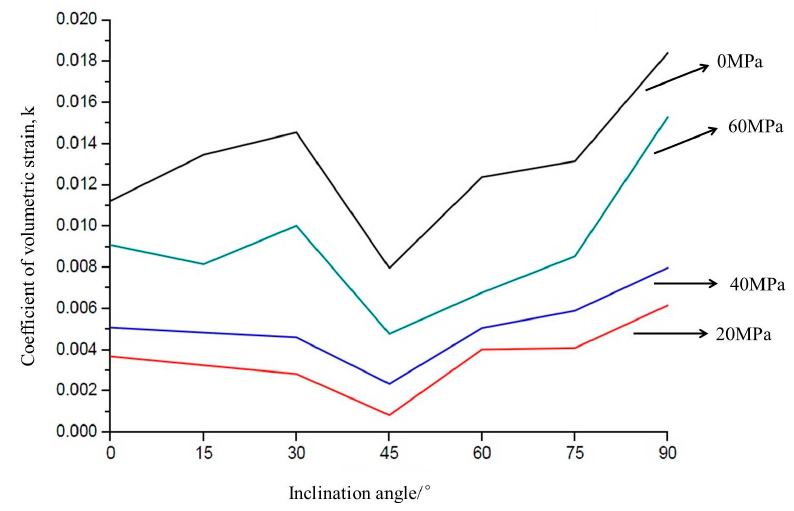
Figure 12. The variation of coefficient of volumetric, k , with the inclination angle ( β ).